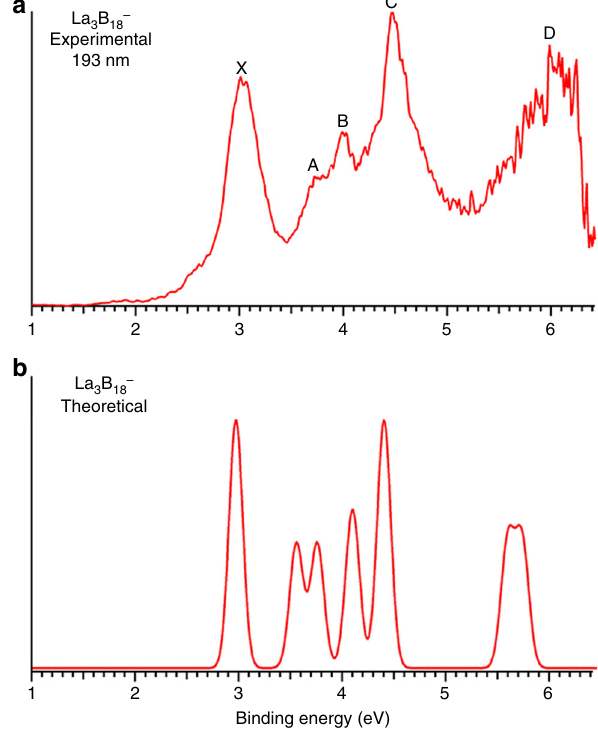
Fig. 1 Photoelectron spectrum of La 3 B 18 – . a At 193 nm. b The simulated